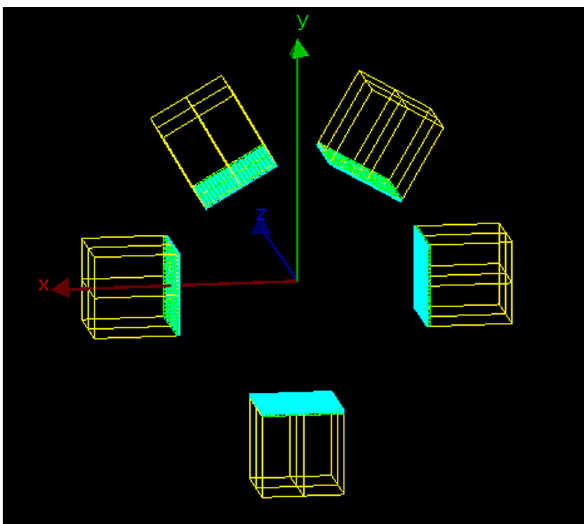
Fig. 21 Simulated spectrometer with relative angular disposition 0 ◦ − 60 ◦ − 120 ◦ − 180 ◦ − 270 ◦ , similar to the setup used in the ATOMKI